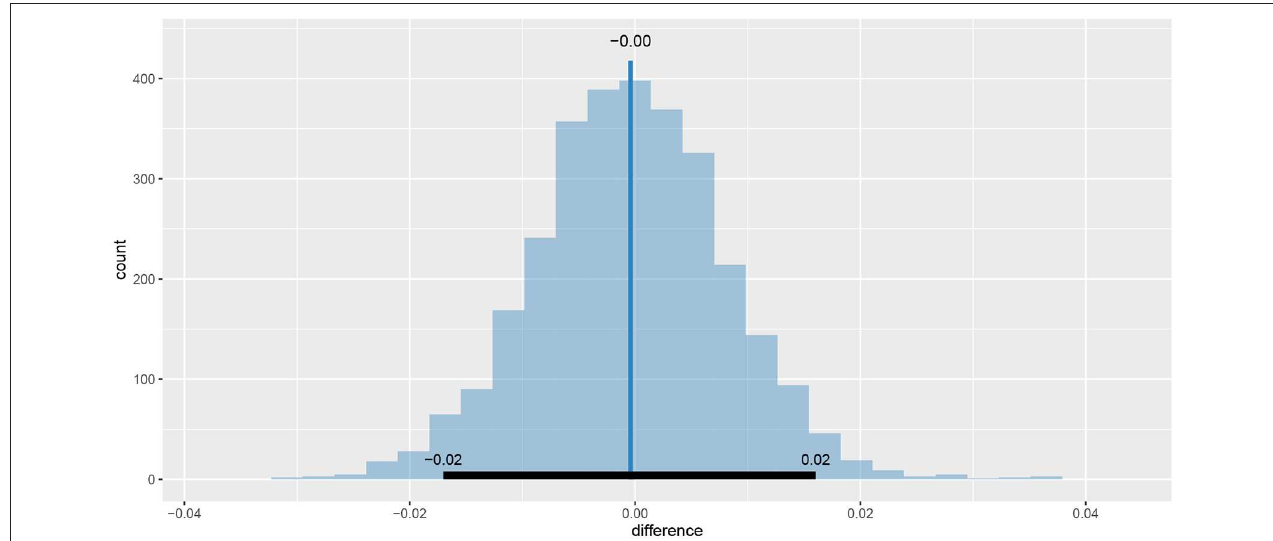
FIGURE 10 | The visualization of the difference between sr_control_fit and sr_test_fit . The histogram visualizes the distribution of the difference, vertical blue line denotes the mean difference and the black band at the bottom marks the 95% HDI interval. Since the 95% HDI of difference includes 0 we cannot claim inequality. If we used a ROPE interval and the whole ROPE interval lied in the 95% HDI interval we could claim equality.